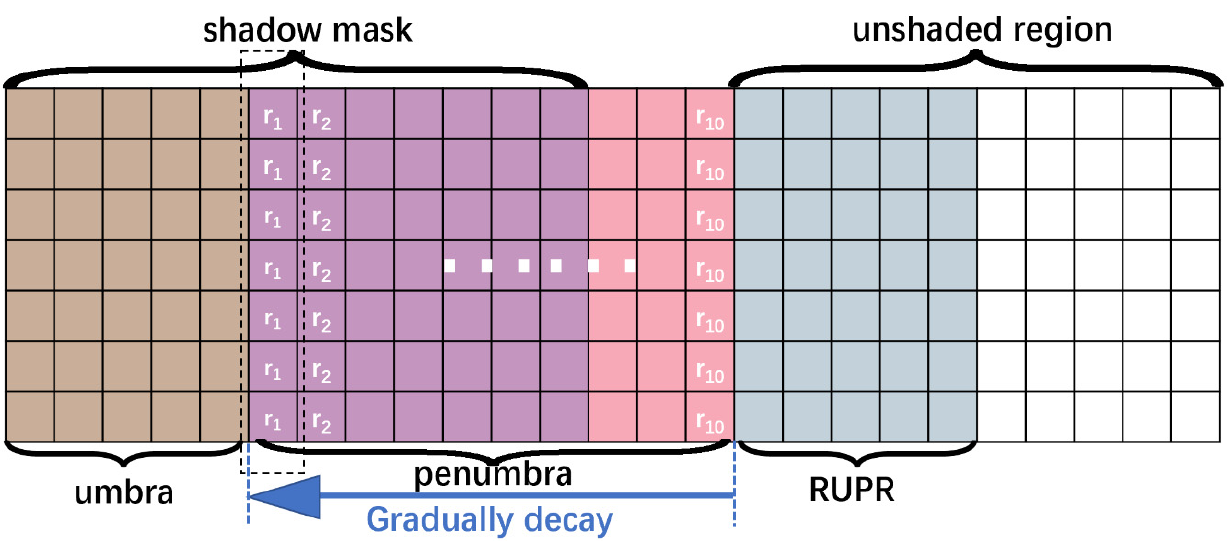
Figure 7. Schematic calculation of r . For each one pixel width region in penumbra, the ration r was updated.